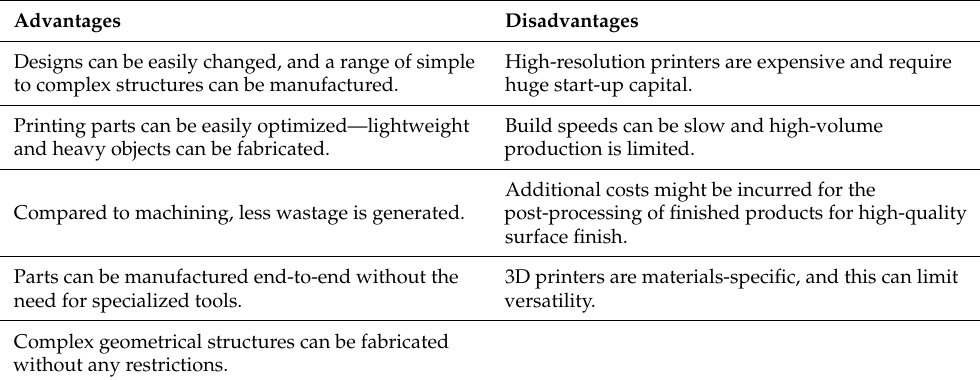
Table 1. Advantages and disadvantages of additive manufacturing